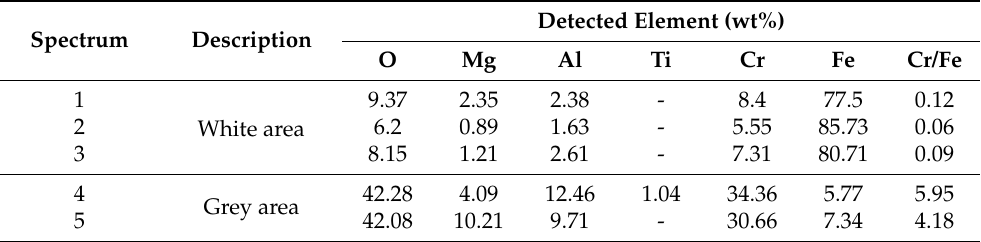
Table 4. Microanalyses by SEM-EDX (wt%) of chromite particle shown in Figure 10c. The sample was pre-oxidized at 1100 ◦ C for 60 min and subsequently reduced at 1100 ◦ C for 60 min at a hydrogen flow rate of 750